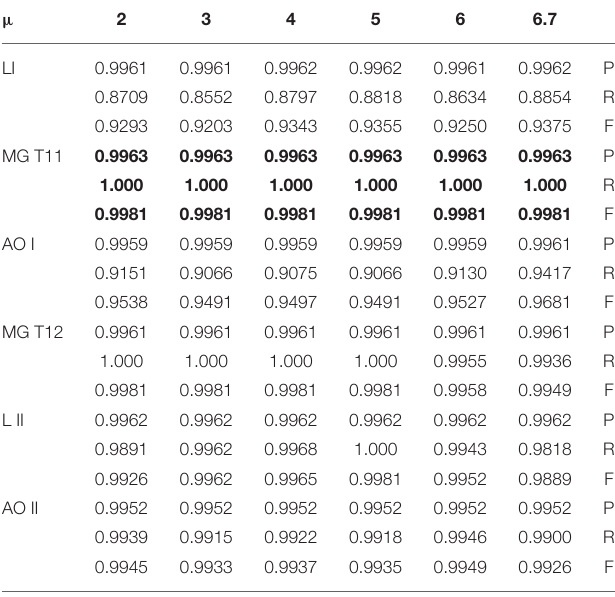
TABLE 2 | Image of group 2 in the range of µ was from 2 to 6.7.